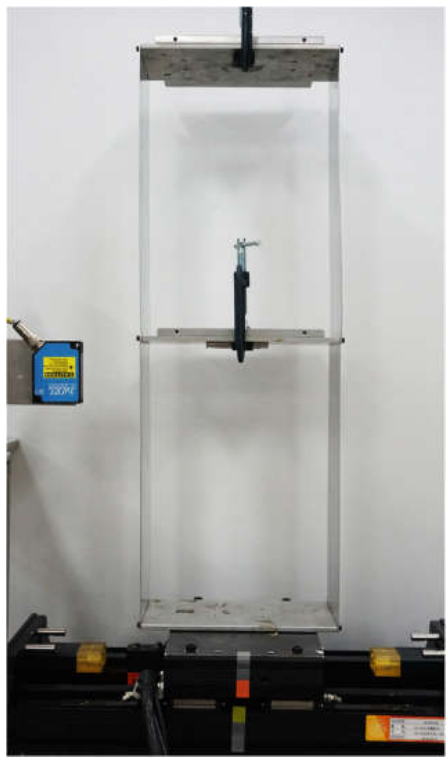
Figure 16. Experimental two-story building model.